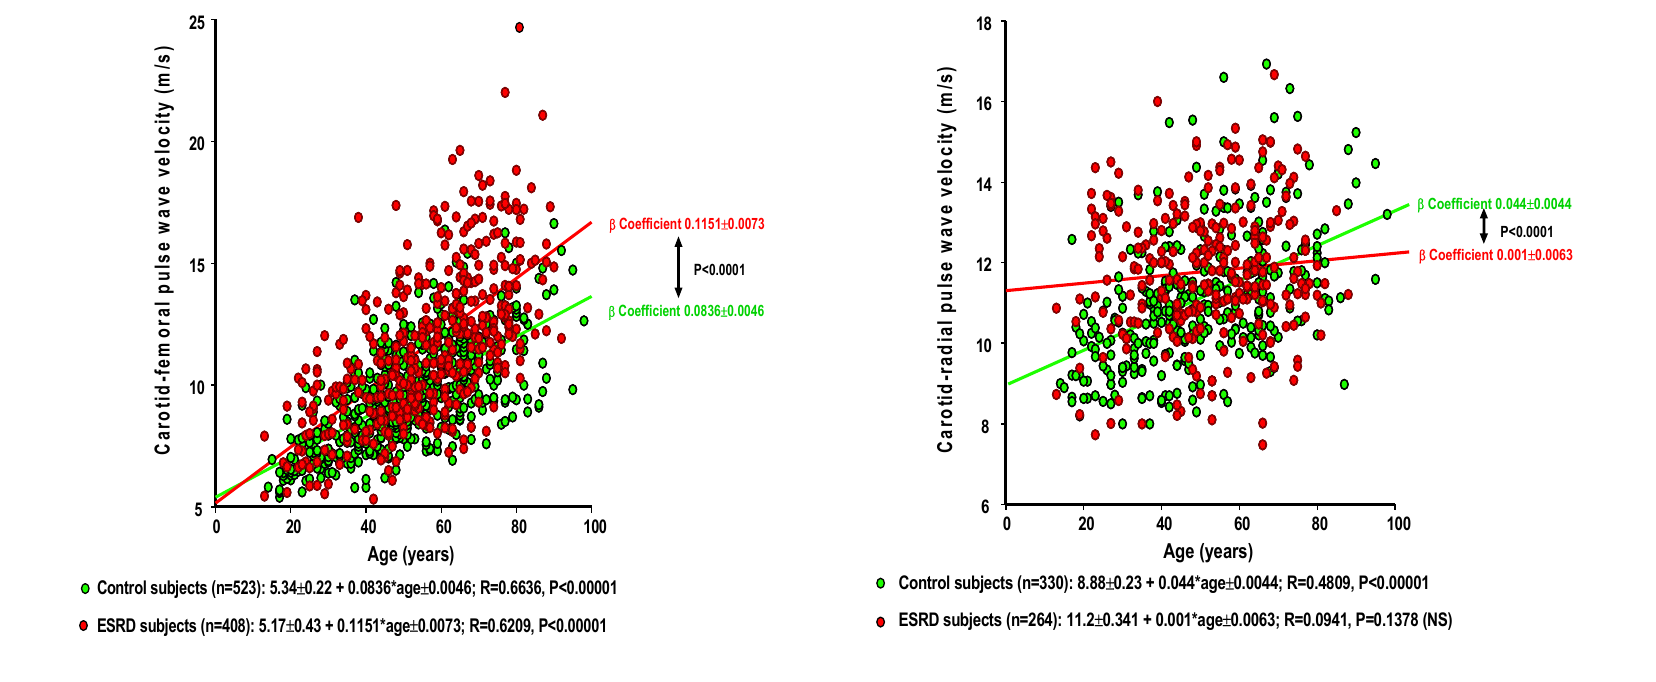
Figure 1. ( A ) The age–carotid–femoral pulse wave velocity linear regression in the general population (green circles) and in dialyzed ESRD patients (red circles). ( B ) The age–carotid–radial pulse wave velocity linear regression in the general population (green circles) and in dialyzed ESRD patients (red circles). *: refer to multiplication sign in the formula.